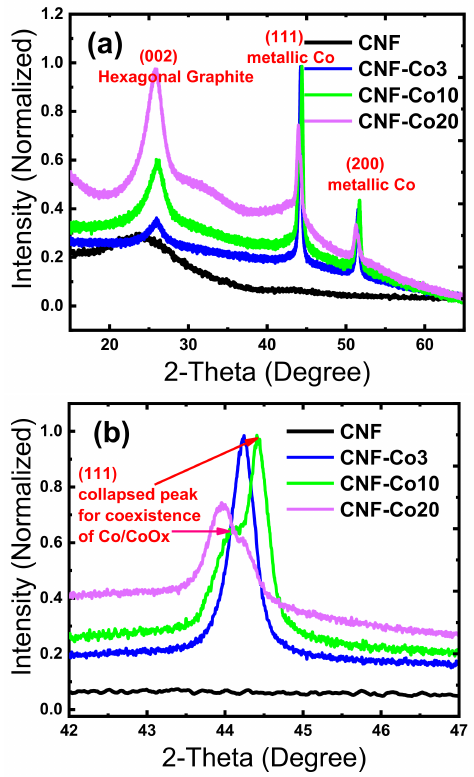
Figure 3. XRD profiles of the prepared free-standing electrodes: ( a ) survey XRD scan; ( b ) high- resolution scan of 111 peak(s) around 44 ◦